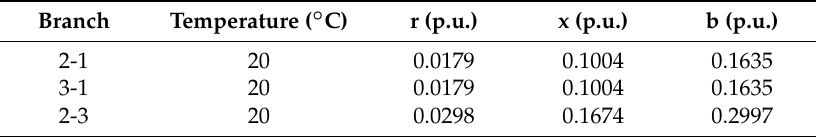
Table 3. The impedance and susceptance when the conductor temperature is 20 ◦ C. r: resistance. x: reactance. b: susceptance. p.u.: per-unit value. Branch 2-1: the line from bus 2 to bus 1. Branch 3-1: the line from bus 3 to bus 1. Branch 2-3: the line from bus 2 to bus 3.